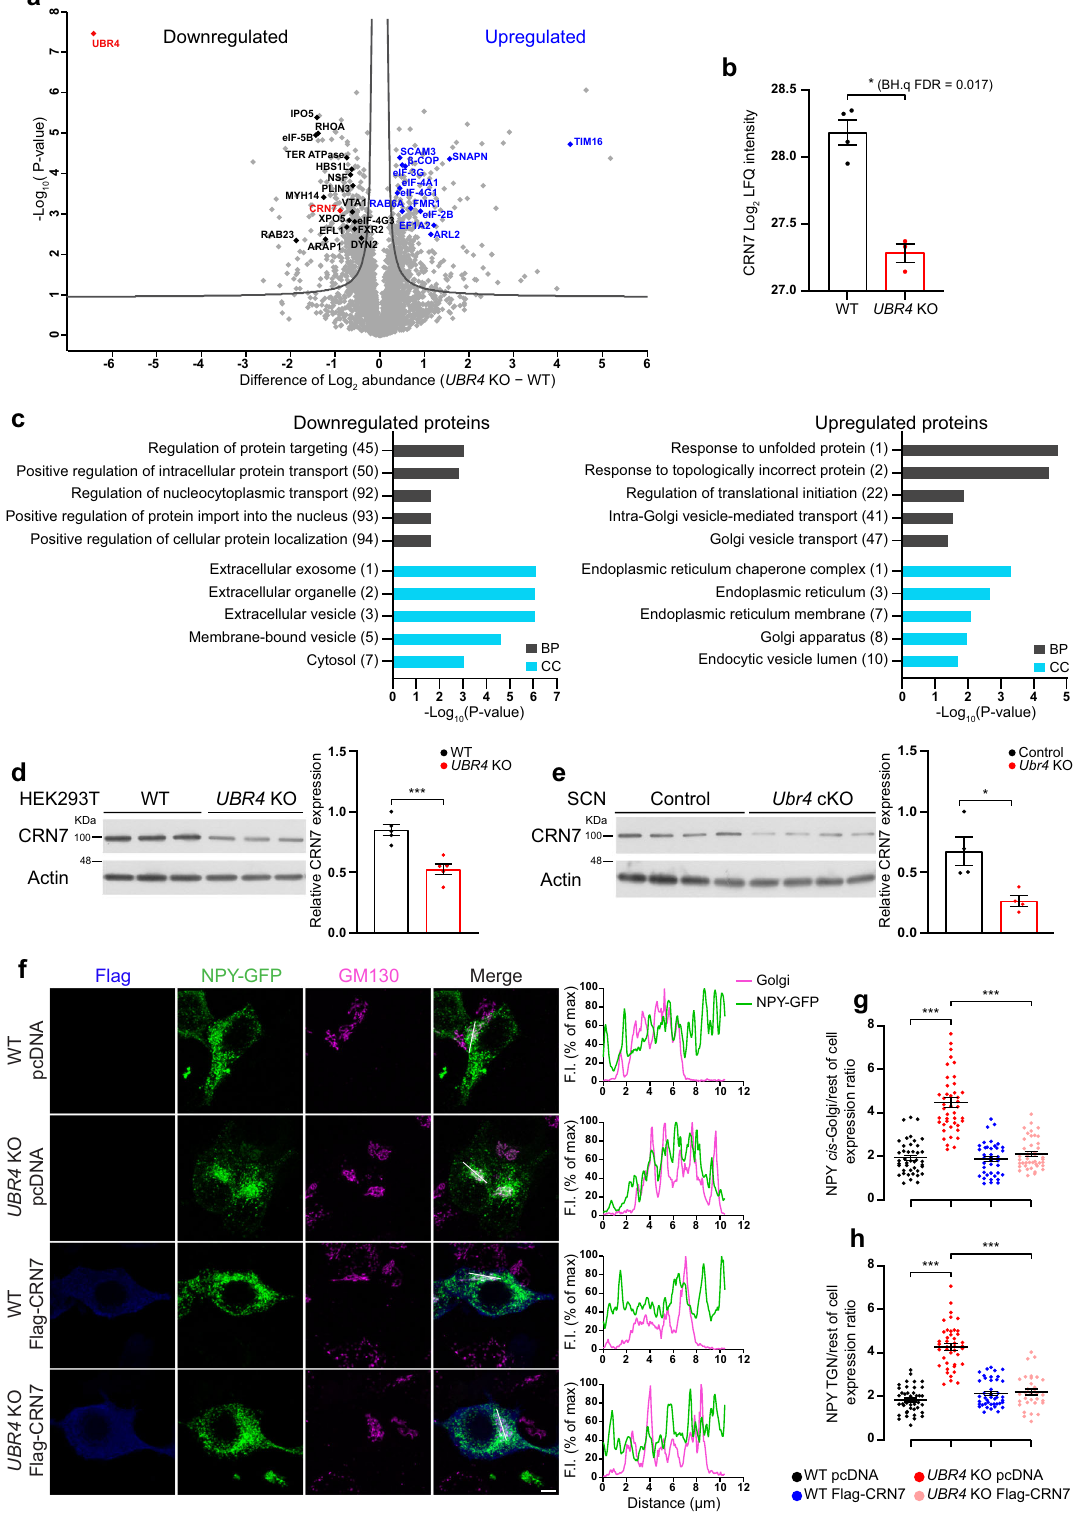
mean of the total daily wheel revolutions was calculated by taking the average of daily wheel revolutions for 7 (LD, DD) or 12 (LL) consecutive days. The period was measured by fi tting a regression line through daily activity onsets or by using the χ 2 periodogram. The DD period reported in Fig. 1d was measured from the 10 days preceding the CT15 LP. Amplitude was measured by χ 2 periodogram and Fast